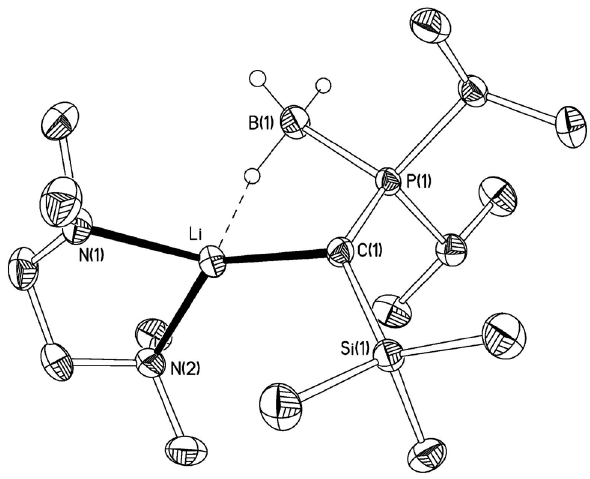
Figure 1 Molecular structure of 6a with 40% probability ellipsoids and with disorder component and C-bound H atoms omitted for